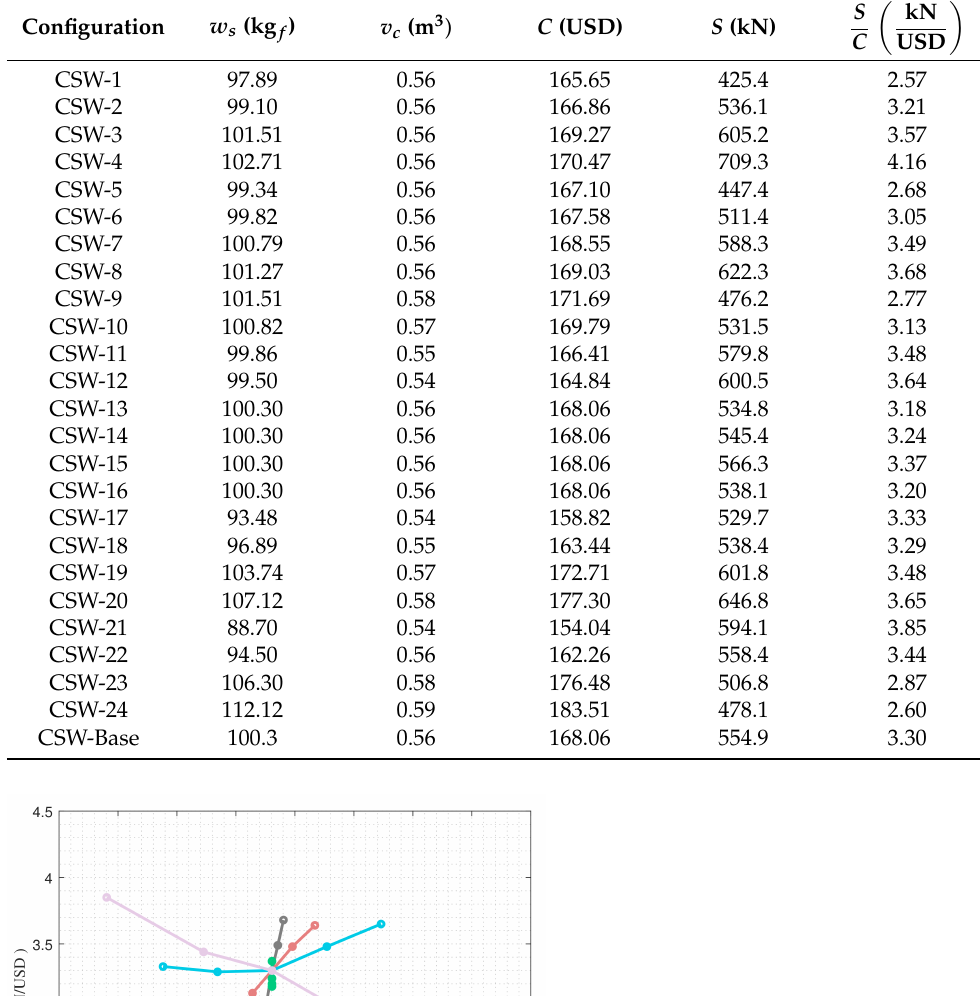
Table 4. Costs and normalised strengths.